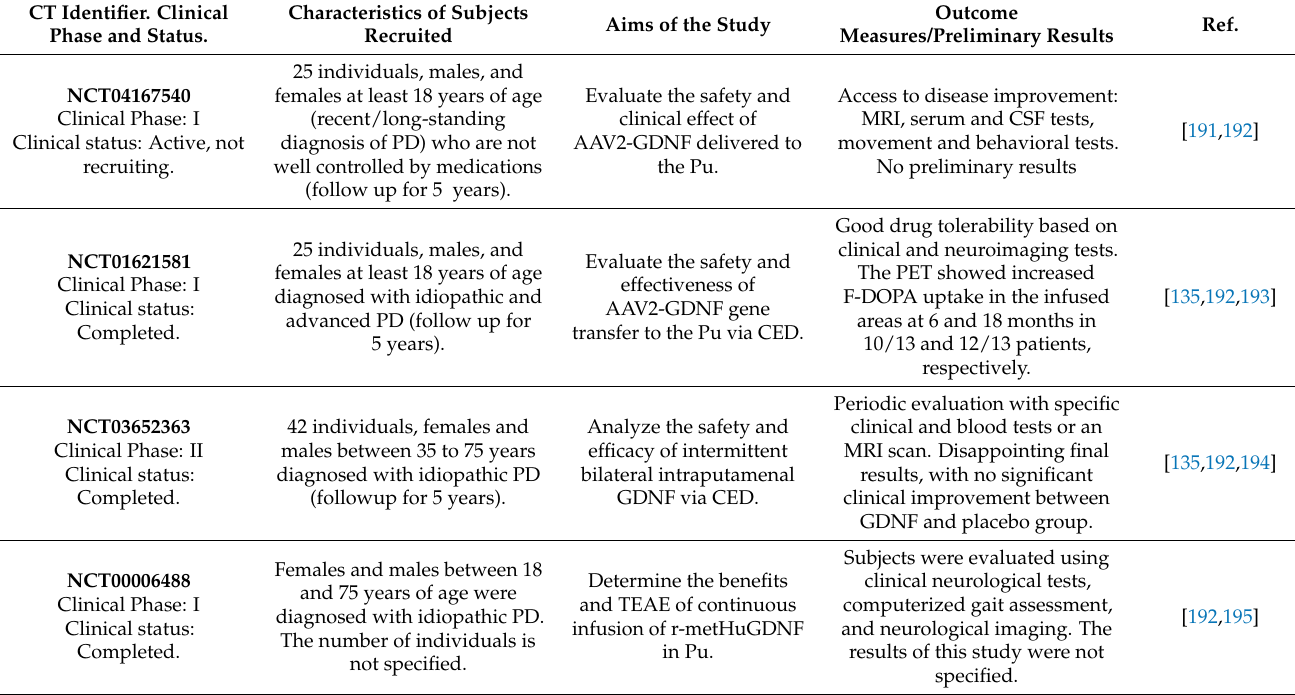
Table 5. GDNF current clinical trials for Parkinson disease, based on NIH ClinicalTrials.gov (accessed on 30 August 2021). CT Identifier. Clinical Phase and